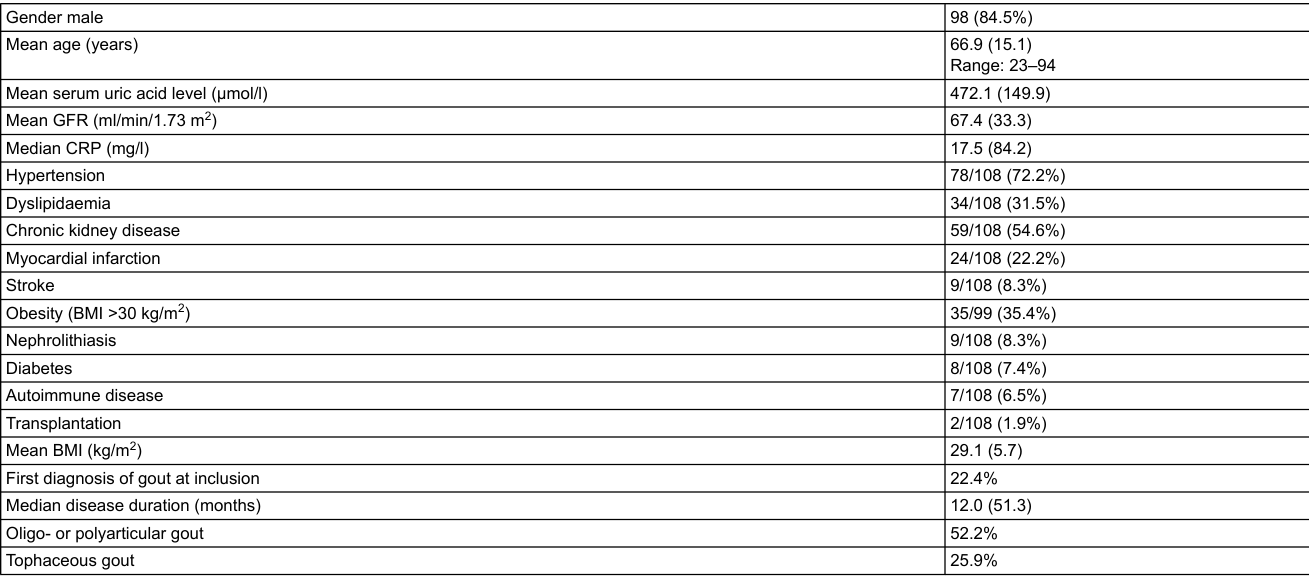
Table 1: Patient characteristics at baseline (n =